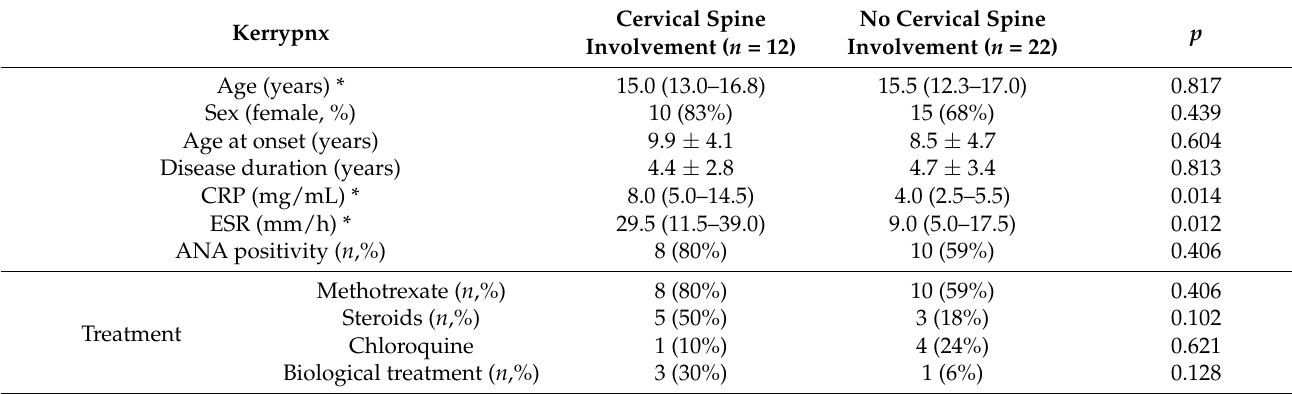
Table 4. Comparison between JIA patients diagnosed with cervical spine involvement on imaging with JIA patients without confirmed cervical spine involvement. Cervical Kerrypnx